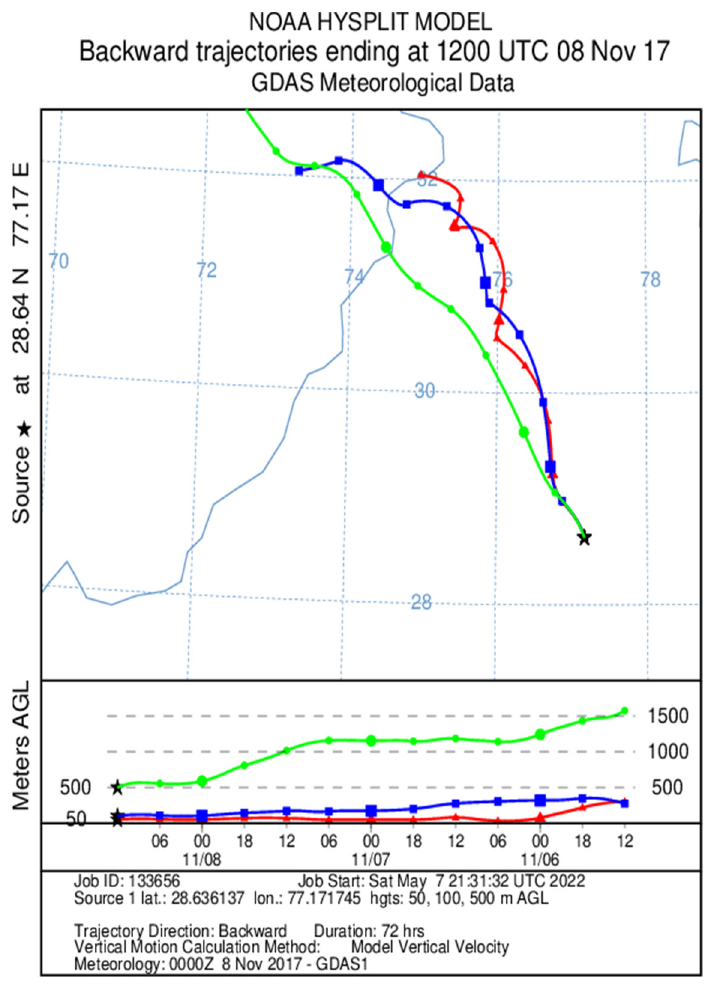
Figure 3. Backward air mass trajectory on 8 November 2017.